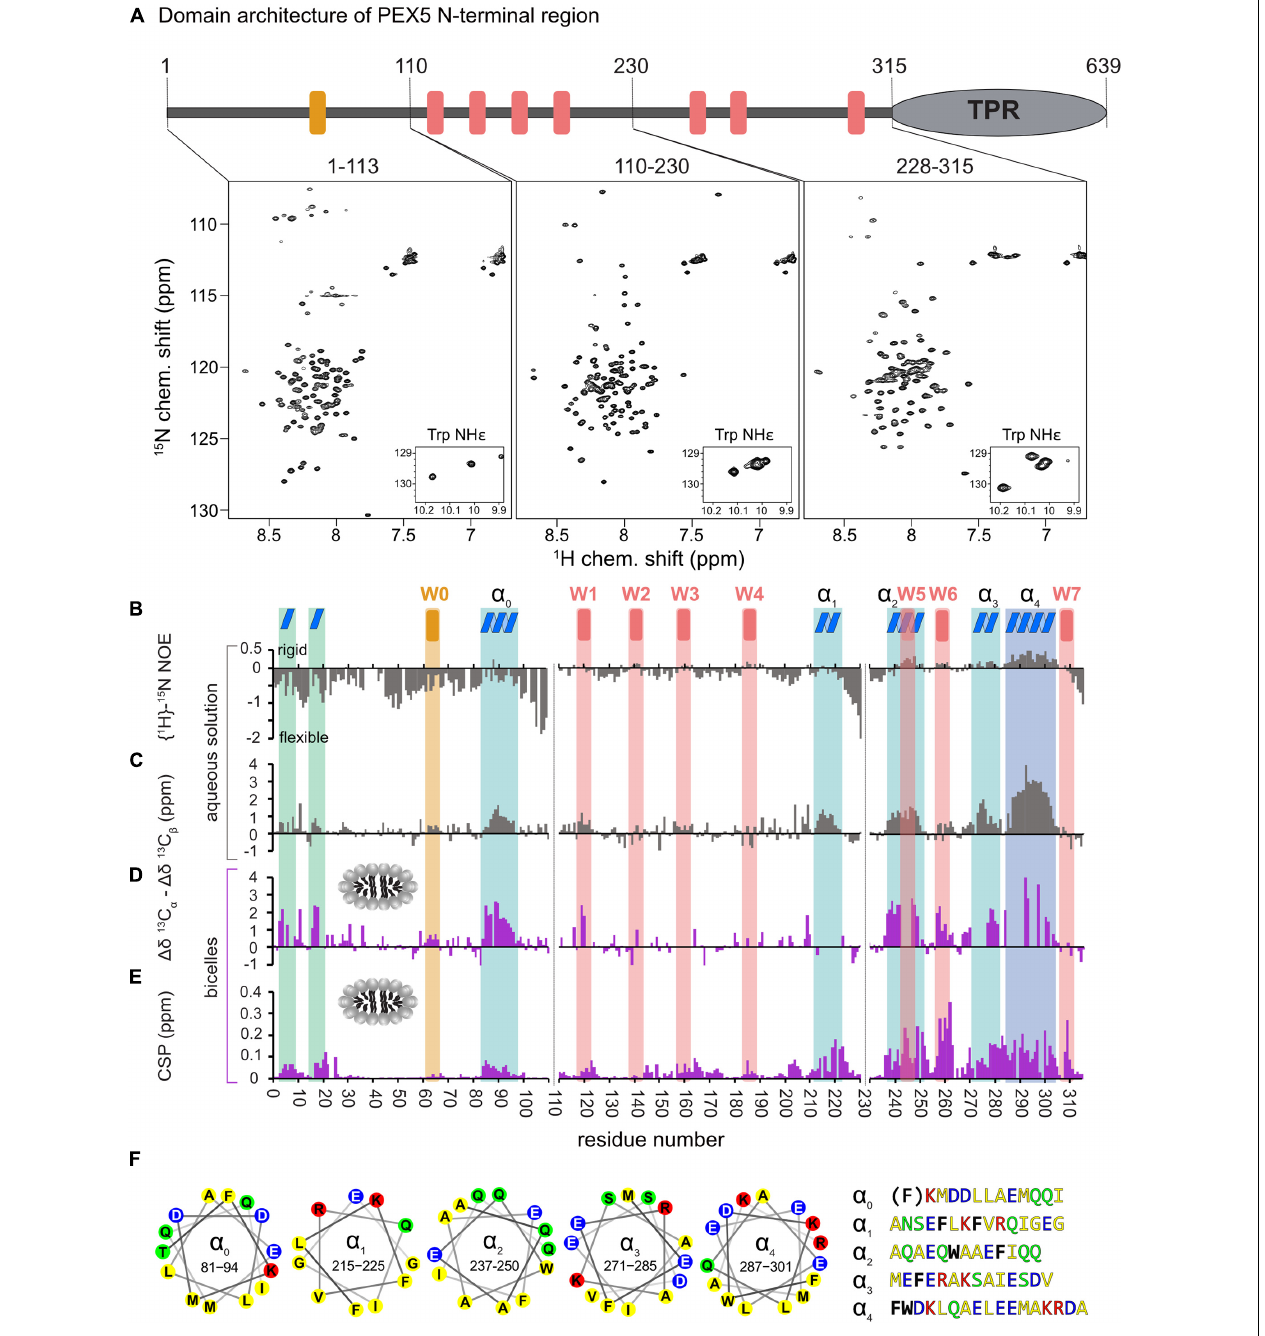
FIGURE 1 | Analysis of PEX5 NTD in the absence and presence of bicelles by NMR spectroscopy. (A) PEX5 NTD domain architecture and 1 H– 15 N HSQC spectra of PEX5 constructs 1–113, 110–230, and 228–315 (B) . { 1 H}- 15 N heteronuclear NOE experiments of the three constructs in aqueous solution. Negative values represent a highly flexible peptide backbone conformation. WF and the WF-like motif W0 are indicated by red or orange bars, respectively. (C) Less flexible regions were classified as helices α 0 – α 4 (blue boxes) based on the secondary chemical shift ( (cid:49) δ 13 C α – (cid:49) δ 13 C β ) (D) . In the presence of bicelles the helices and two α -turns located in the first 20 aa are stabilized, as indicated by the secondary chemical shift (E) . Chemical shift perturbations extracted from 1 H- 15 N HSQC experiments demonstrate membrane binding which is mostly mediated by WF6 and the amphipathic helices α 0 – α 4 visualized as helical wheels in (F) . The residues are color coded in yellow for hydrophobic, green for polar, blue for negative charged and red for positive charged sidechains. Phe and Trp residues are shown in black and bold letters with exception of the Phe in α 0 which does not contribute to the hydrophobic face of the helix.